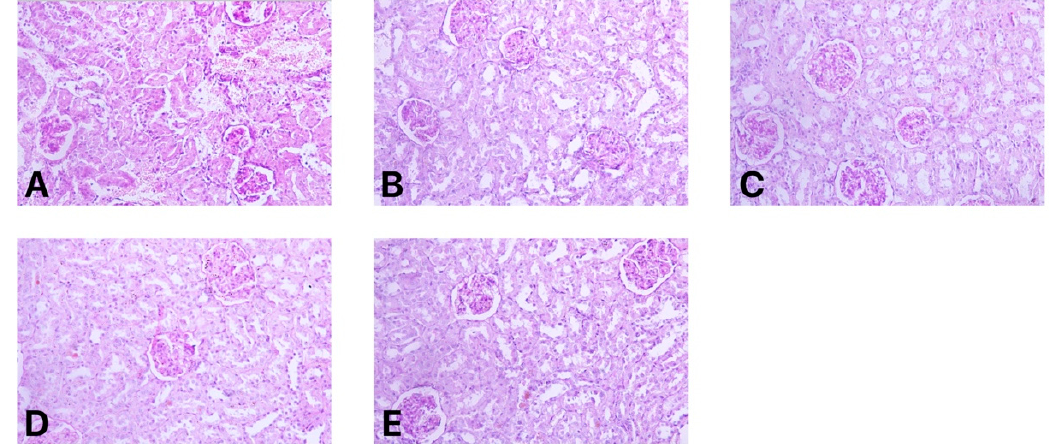
Figure 2. Histopathological images of rat kidneys; ( A ) Polymyxin B (Control)-Showing necrotic changes in kidney tissues with congestion and vacuolization. ( B ) VRP-034_F21-Kidney showing normal organization of glomeruli, mild tubular damage with vacuolization. ( C ) VRP-034_F22- Showing normal glomerular and tubular histology. The tubules were largely intact without the presence of any mononuclear infiltrates in the interstitium, and blood vessels were also unremarkable. ( D ) VRP-034_F23-Showing normal glomerular and tubular histology. The tubules were largely intact without the presence of any mononuclear infiltrates in the interstitium and blood vessels were also unremarkable. ( E ) VRP-034_F24-Showing normal organization of glomeruli, mild tubular damage with vacuolization.